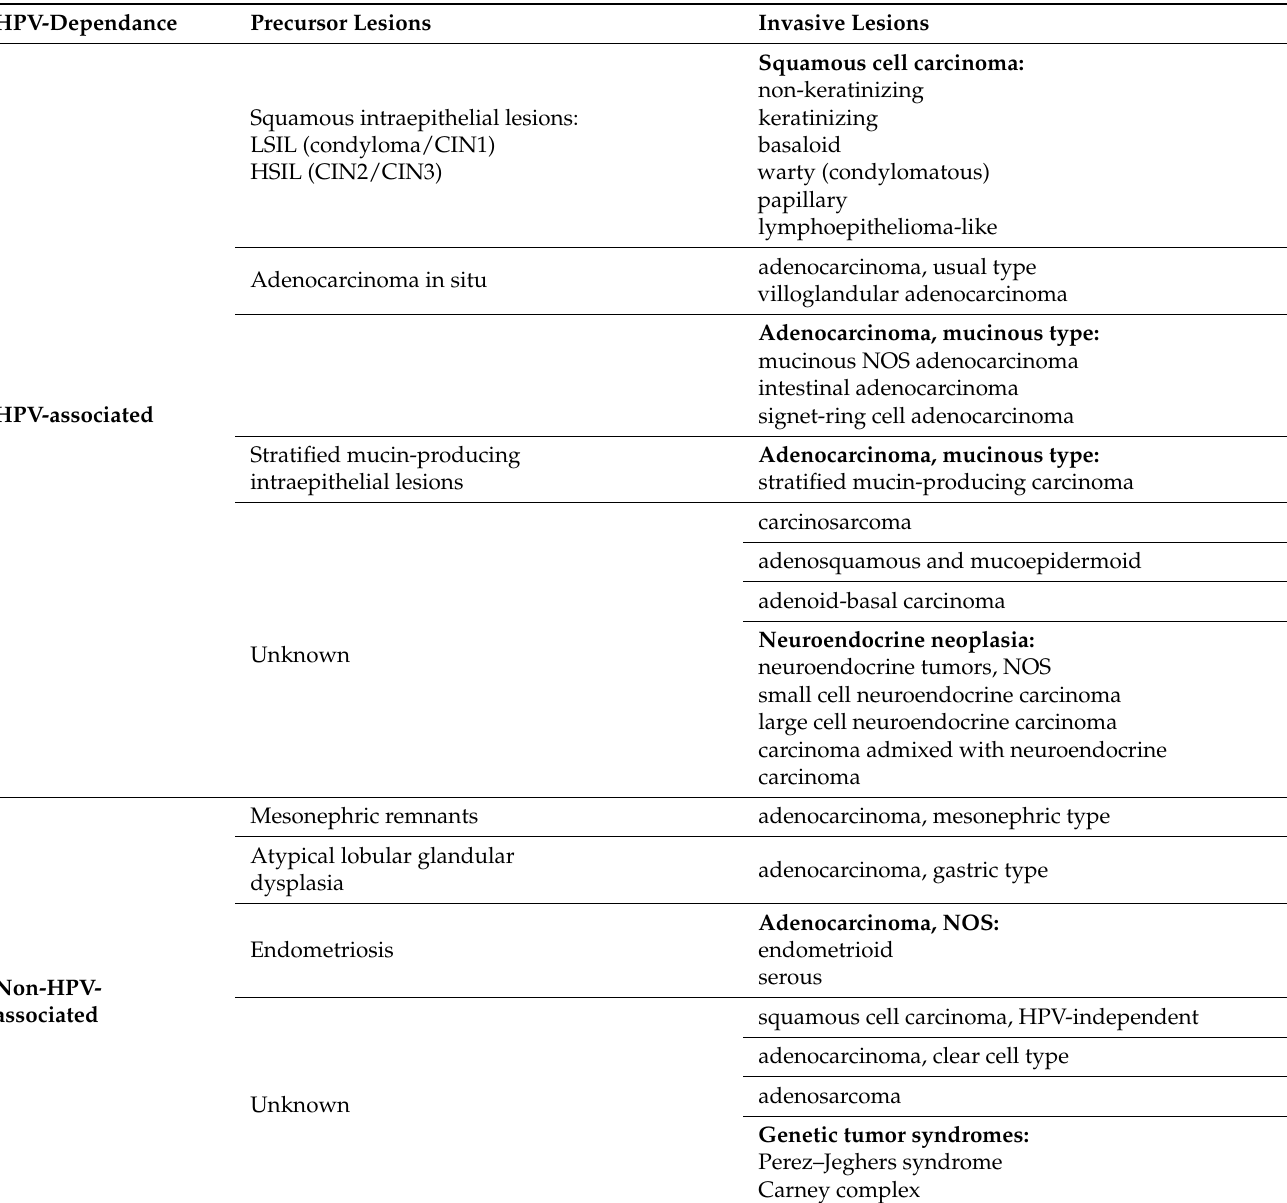
Table 2. HPV-dependency in cervical cancer types, according to the WHO Classification of Tumors; NOS—not otherwise